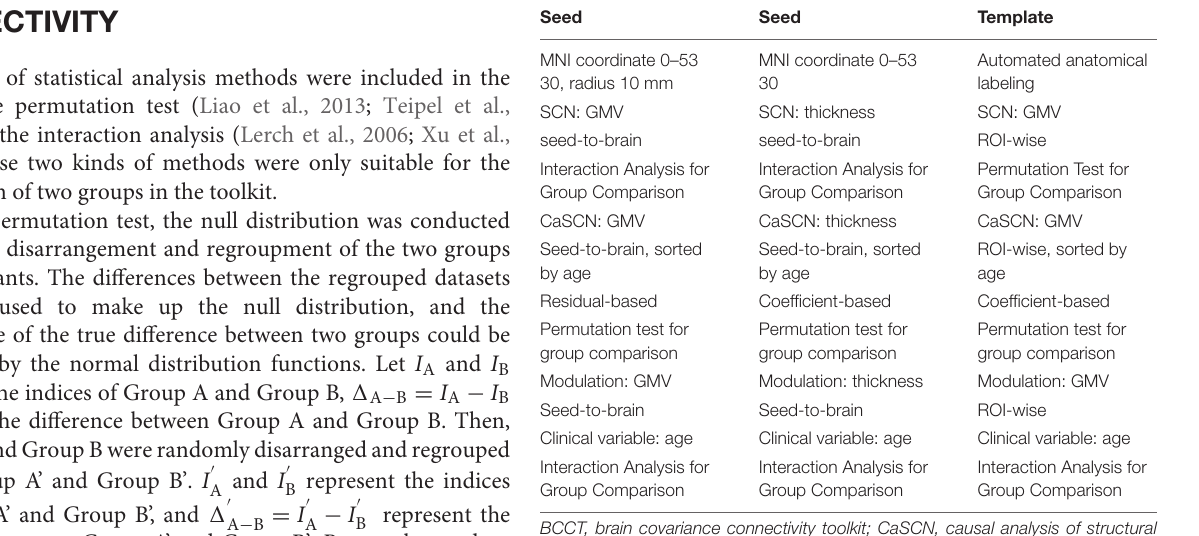
TABLE 1 | The parameters of the demo dataset for BCCT.